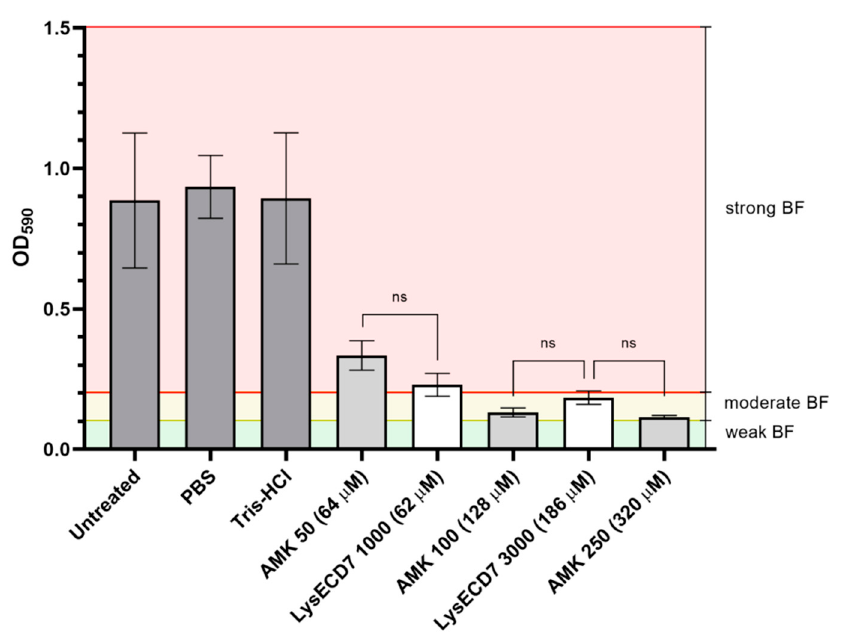
Figure 2. Antibacterial activity of the LysECD7 and amikacin (AMK) against forming biofilm of K. pneumoniae Ts 141-14 measured after 24 h of culture incubation; Untreated—untreated BF; PBS—BF treated with Phosphate-Buffered Saline; Tris-HCl—BF treated with 20 mM Tris-HCl buffer; AMK 50 (64 µM)—forming BF treated with 50 µg/mL AMK; LysECD7 1000 (62 µM)—forming BF treated with 1000 µg/mL LysECD7; AMK 100 (128 µM)—forming BF treated with 100 µg/mL AMK; LysECD7 3000 (186 µM)—forming BF treated with 3000 µg/mL LysECD7; AMK 250 (320 µM)—forming BF treated with 250 µg/mL AMK. Weak, moderate and strong BF were estimated according to Stepanovic et al., 2007 [21]. Data are shown as mean ± standard deviation; “ns”—no significant differences were observed (one-way ANOVA with Dunnett’s multiple comparisons test). Differences between treatments and controls were significant ( p < 0.0001).